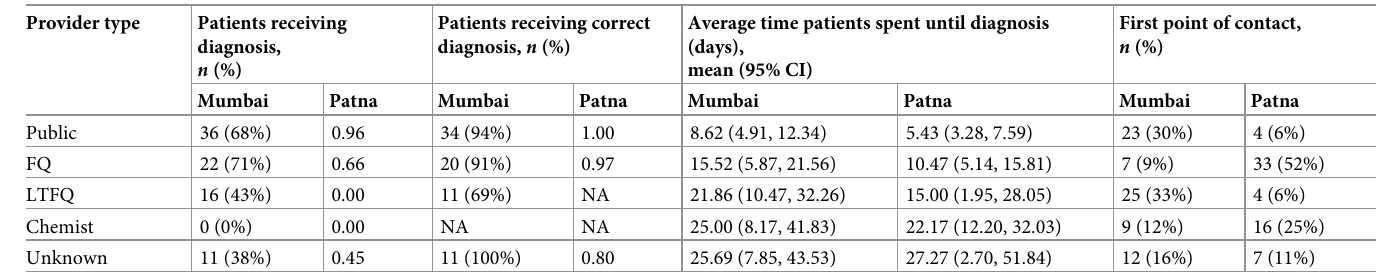
Table 2. Aggregated descriptive statistics of patient pathway survey data. Provider type Patients receiving